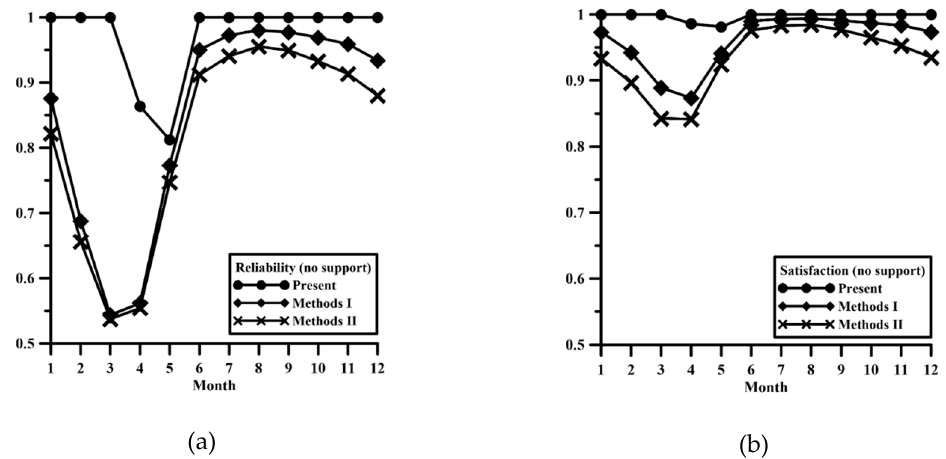
Figure 18. Monthly ( a ) reliability and ( b ) satisfaction of the water supply for Scenario I.